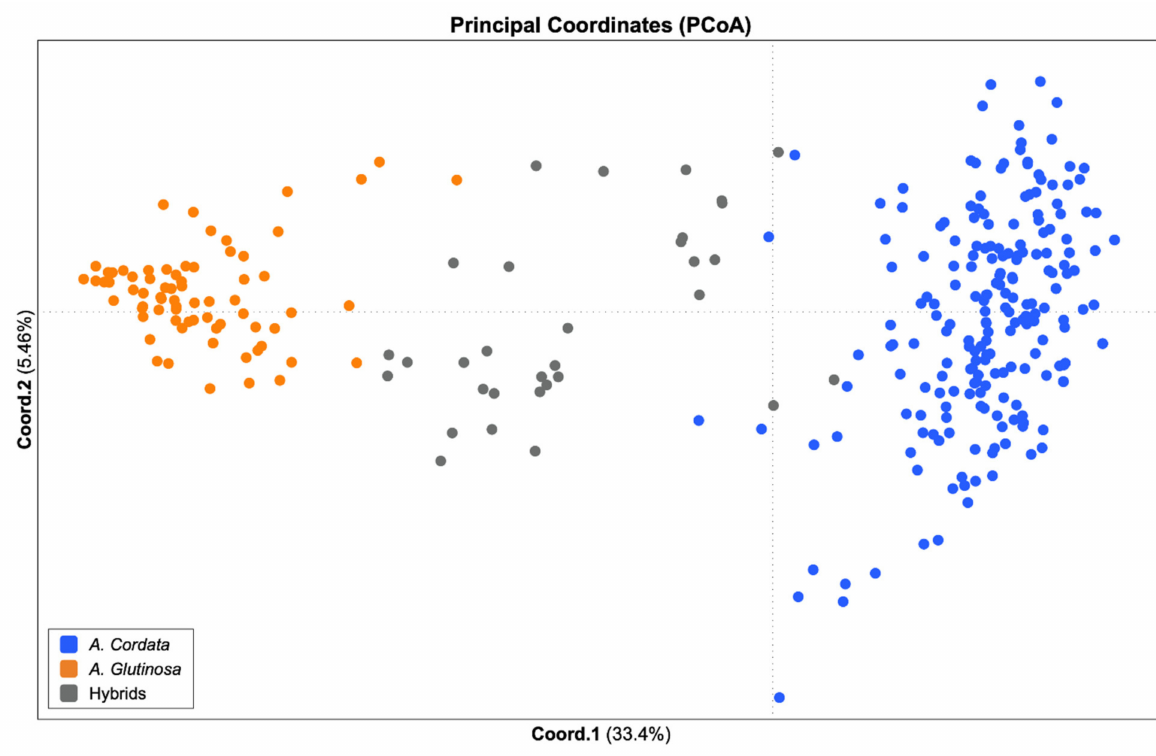
Figure 5. Principal Coordinate Analysis (PCoA) of pair-wise genetic distance based on the complete set of individuals of A. cordata , A. glutinosa and hybrids. Percentages of variation of the two axes are explained in the figure. Blue dots, A. cordata individuals; orange dots, A. glutinosa individuals; grey dots, hybrid